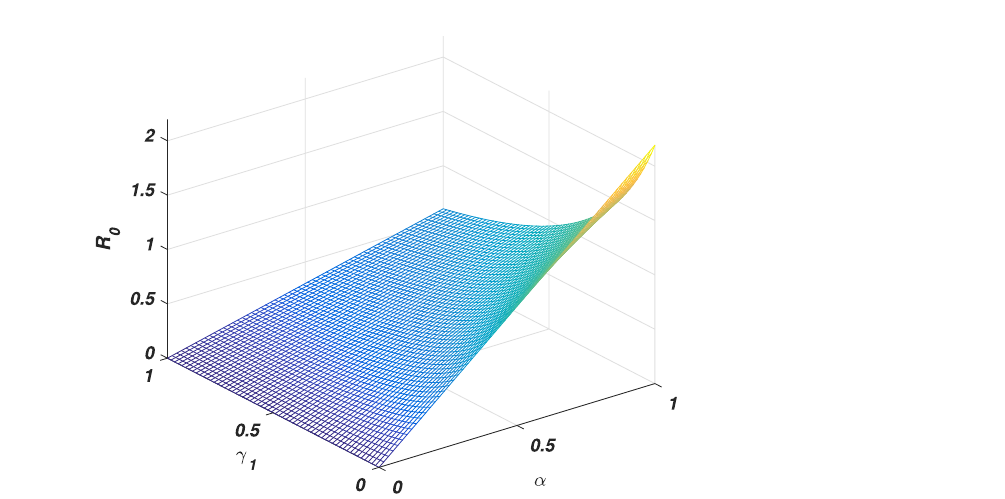
Figure 3. The graph demonstrate the variation of the basic reproductive number against parameters α and γ 1